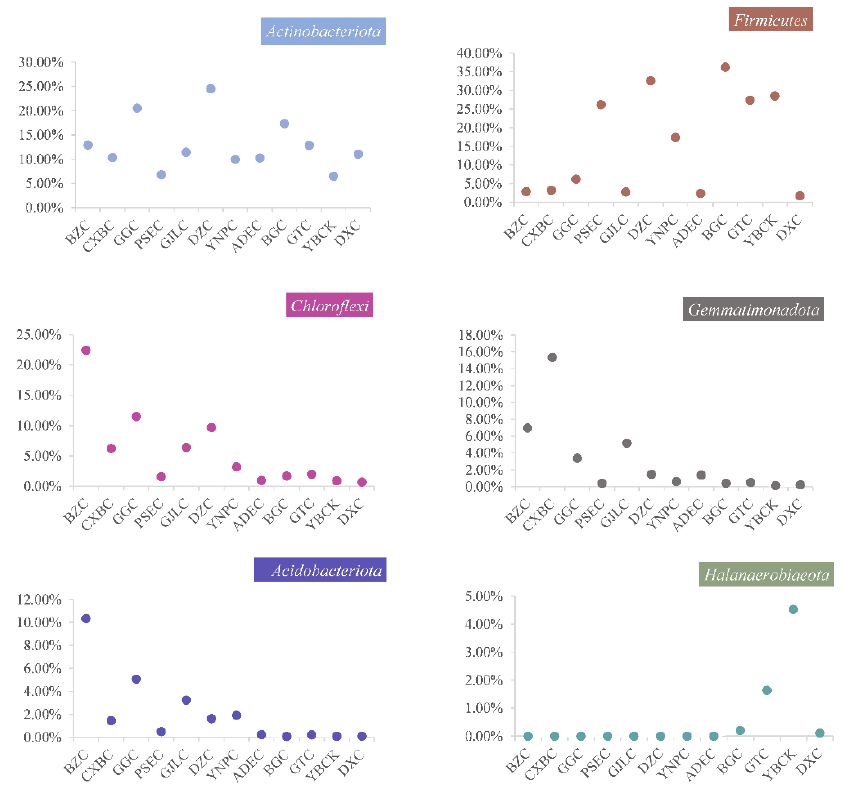
Figure 5. The relative abundance of the major phyla/classes along a salinity gradient in the 12 lakes on the Tibetan Plateau, China.